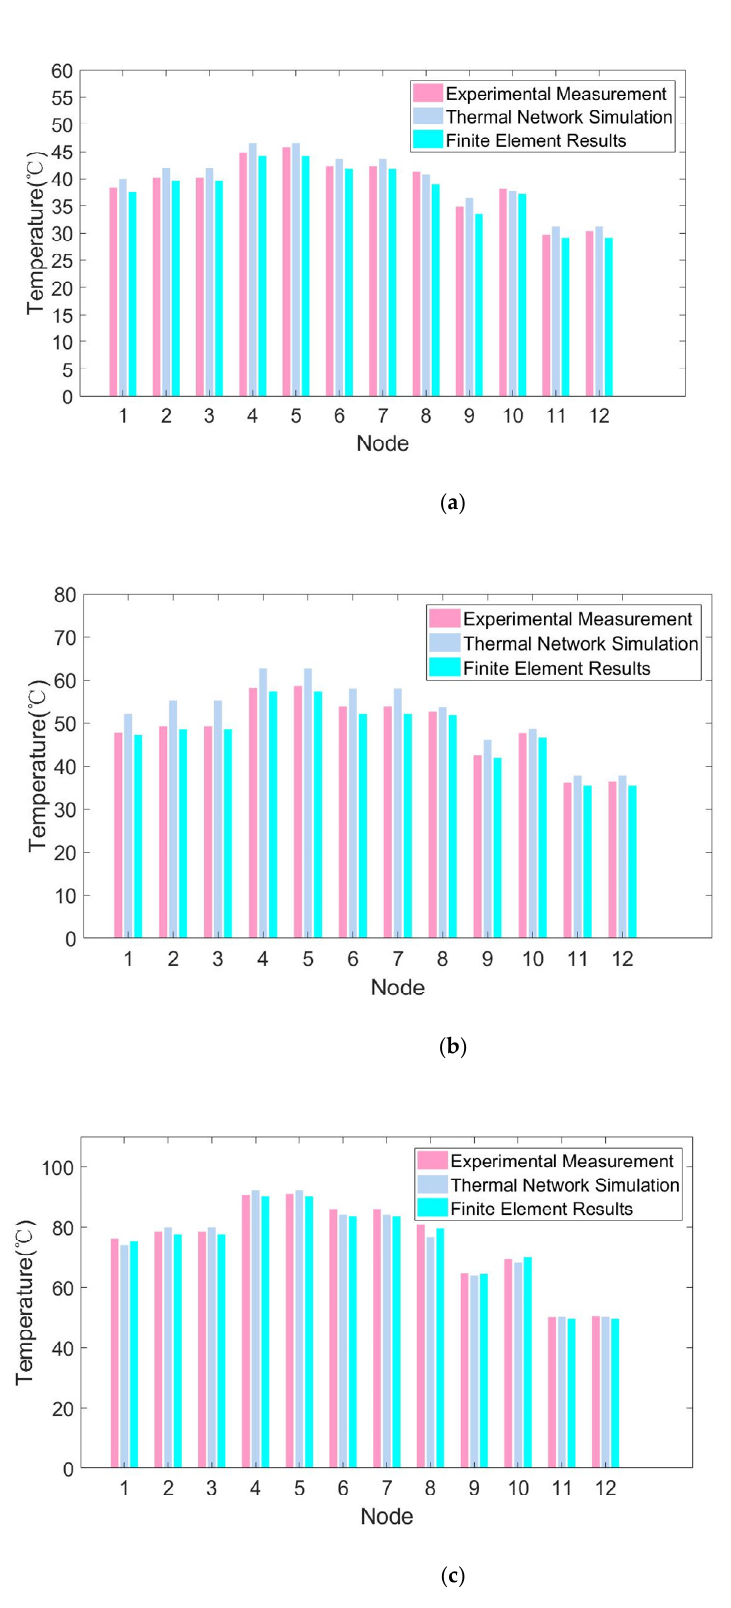
Figure 13. Steady-state temperature of each reactor node: ( a ) ± 550 V; ( b ) ± 750 V; ( c ) ± 1050 V. From the experimental results, we can see that the thermal network model has the highest accuracy. When the voltage is ±550 V, ±750 V and ±1050 V, the error is 3.8%, 3.1%